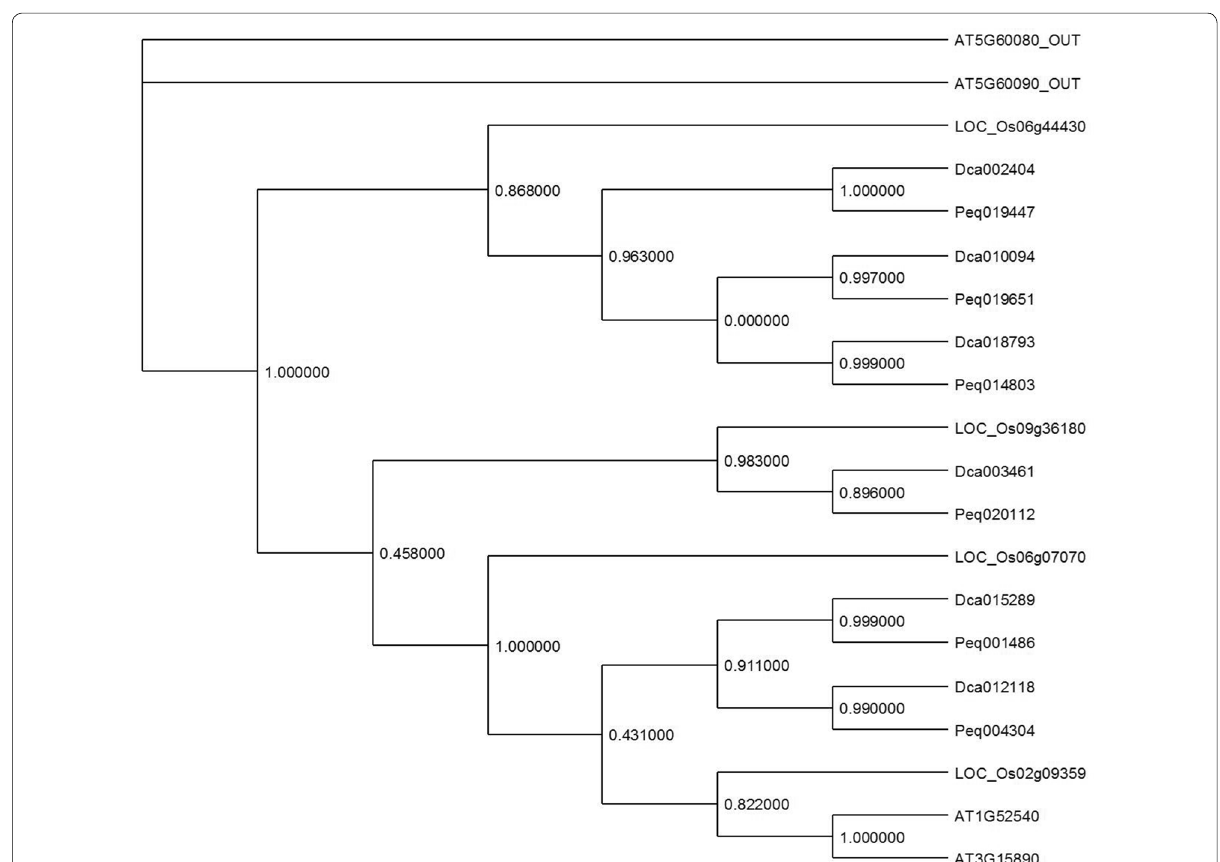
Fig. 2 Phylogenetic tree of the RLCK‑XV SG. The phylogenetic tree of the RLCK‑XV classified sequences has been built with PHYML (default parameters,) (Guindon et al. 2009) based on the MAFFT (Katoh and Standley 2014) alignment of full‑length amino‑acid sequences. Two Arabidopsis sequences (noted “OUT”) have been added as outgroup to build the